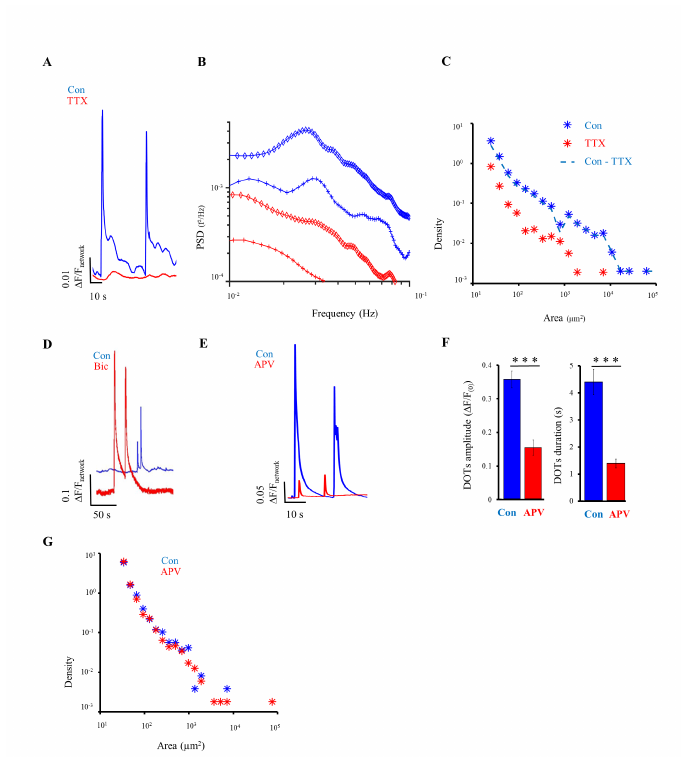
Figure 2: Blockade of voltage – gated sodium channels (by TTX) and glutamate NMDA receptors (by APV) on cortical slices. (A) DOTs observed in control conditions (blue trace) are abolished in the presence of 10 µM TTX (red trace), as shown by the computation of ΔF/F network . (B) Power Spectrum Density (PSD) computed as the average PSD of optical recordings from small regions corresponding to GABA+ neurons in control (blue traces) and in TTX (red traces) from two representative experiments (rhombus, 41 GABA+ neurons; crosses, 37 GABA+ neurons). (C) Density vs area of events in control (blue marks), in TTX (red marks) and in control-TTX (blue dotted line) in one experiment. From three representative experiments: n = 16714 events detected in Con, n = 14007 in Con-TTX; n = 68948 in Con, n = 53566 in Con-TTX; n=32312 in Con, n=21586 in Con-TTX (p>0.05 in all three cases, Kruskal-Wallis test). (D) ΔF/F network in control conditions (blue trace) and after application of Bicuculline 50 µM (red trace). (E) ΔF/F network in control conditions (blue trace) and after application of APV 50 µM (red trace). (F) Average amplitudes and duration of DOTs in control (blue bars) and in APV (red bars): 0.34 ± 0.03 ΔF/F (0) and 4.33 ± 0.49 s for control, 0.15 ± 0.02 ΔF/F (0) and 1.32 ± 0.16 s for APV. These average values were obtained from 3 experiments in control and APV conditions, subsequently: n = 32 (3) DOTs (slices) for control, n = 45 (3) DOTs (slices) for APV. ⃰⃰⃰ ⃰ ⃰ p < 0.001 Kruskal Wallis test. (G) Density vs area of events in control (blue marks) and in APV (red marks) in a representative